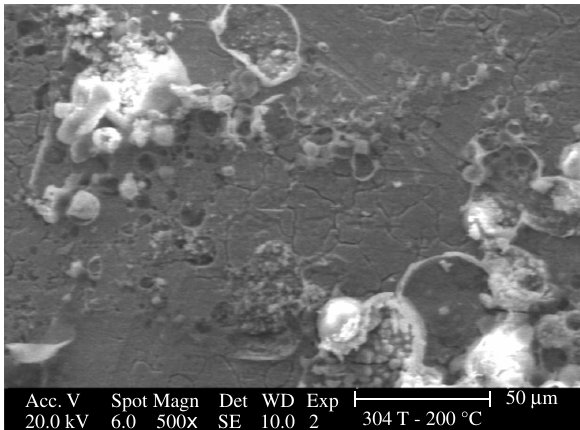
Figure 2. Sample of the AISI 304 steel heat treated in 200 °C.